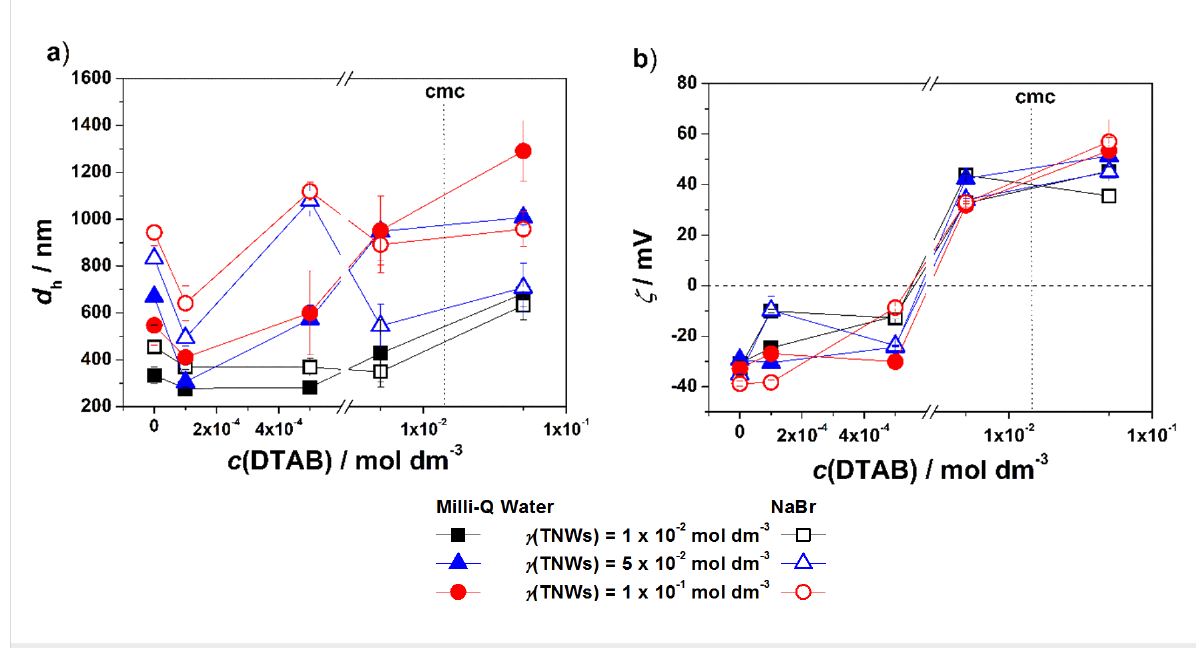
Figure 3: The d h (a) and (b) zeta potential ( ζ ) of DTAB/TNWs in Milli-Q water and 1 × 10 − 3 mol dm − 3 NaBr after 24 h. γ (TNW)/g dm − 3 = 1 × 10 − 2 , 5 × 10 − 2 , 1 × 10 − 1 . θ = 25 °C. The critical micelle concentration (cmc) of DTAB is marked by the dotted line. The lines connecting the data points are a guide for the